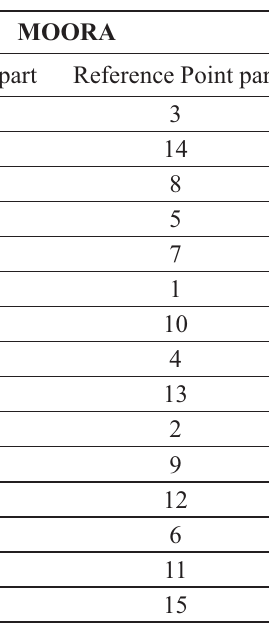
Table 3. Ranking of the 15 contractors by the two parts of MOORA